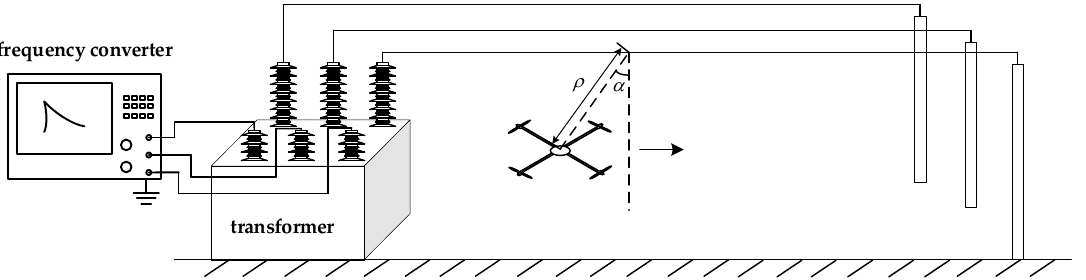
Figure 22. Schematic diagram of the experimental platform.